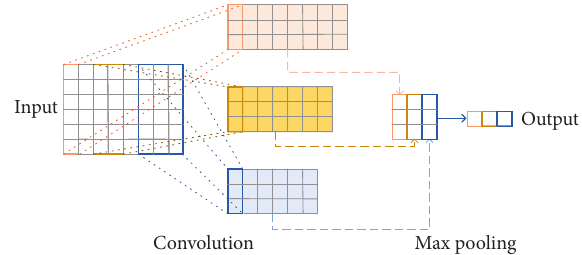
Figure 4: The process of CNN extracting sentence